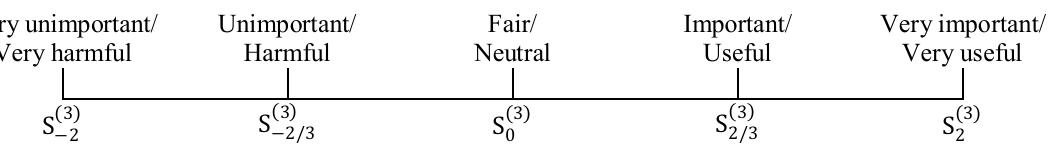
Fig. 2. A set of five linguistic labels S(3)